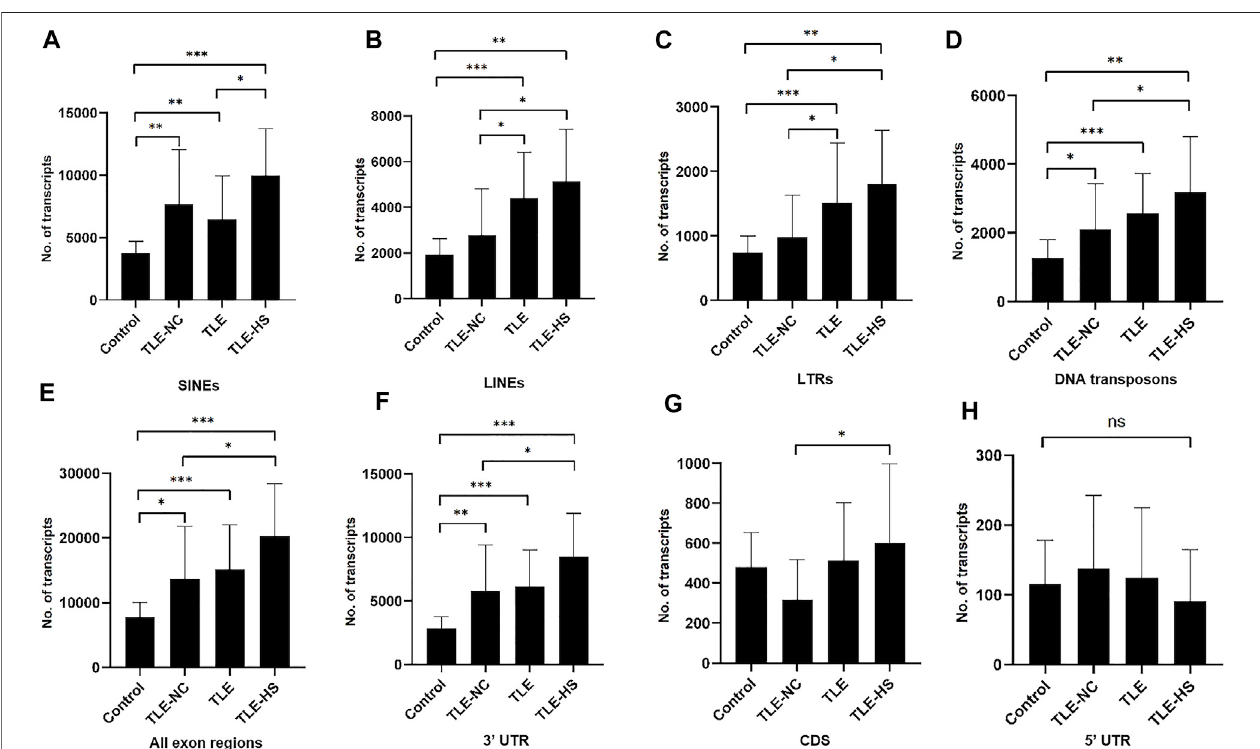
FIGURE1| DifferentialexpressionofMEsingenetranscriptsamongdifferenthumanepilepticgroups.ThefrequencyofMEsingenetranscripts(allexonregions)in each sample group is expressed as the average number of MEs per million assembled transcripts for SINEs (A) , LINEs (B) , LTRs (C) , and DNA transposons (D) in differenthumanepilepticgroups.ThefrequencyofMEsingenetranscripts(allexonregions)ineachsamplegroupisexpressedastheaveragenumberofMEspermillion assembled transcripts in all transcript regions (E) , 3 ′ UTR regions (F) , CDS regions (G) , and 5 ′ UTR regions (H) . The statistical signi fi cance of the differences betweentwosamplegroupsisindicatedbythebracketlinesatthetopofthebarplotswith p -value < 0.001indicatedby “ *** “ , p -value < 0.01indicatedby “ ** “ ,and p -value < 0.05 indicated by “ * ” above the connecting